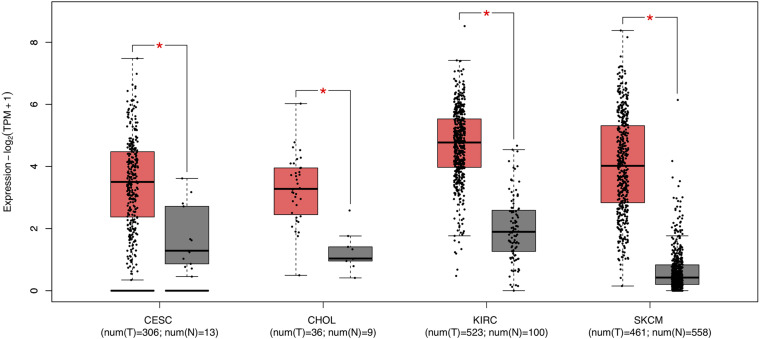
Box plots of FCGR1A expression between tumor and normal tissue in four cancer types. *P < 0.05.